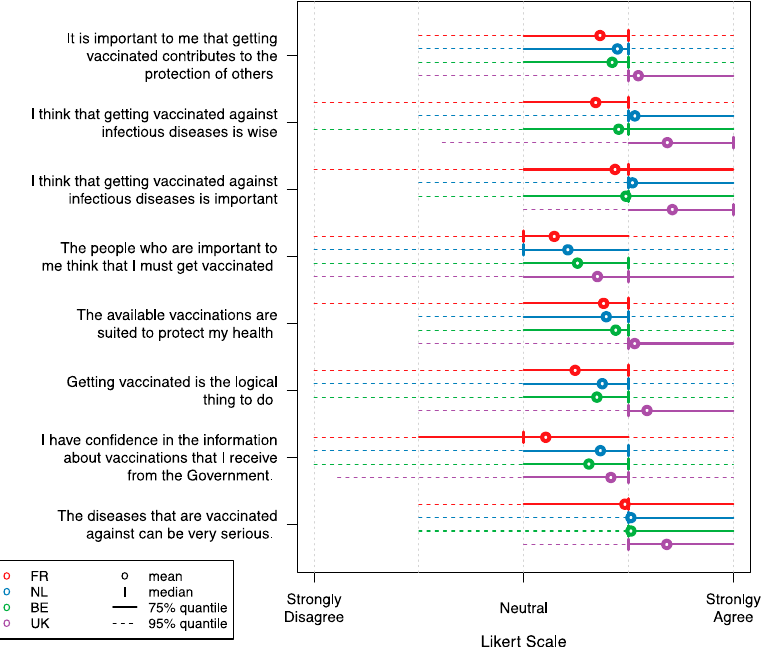
Figure 1. Likert scale responses for a selection of vaccination attitude statements in the ‘adult’ group. Abbreviations: FR: France; NL: the Netherlands; BE: Belgium; UK: United Kingdom. Estimates for the Netherlands are derived from Hoogink et al. [31].